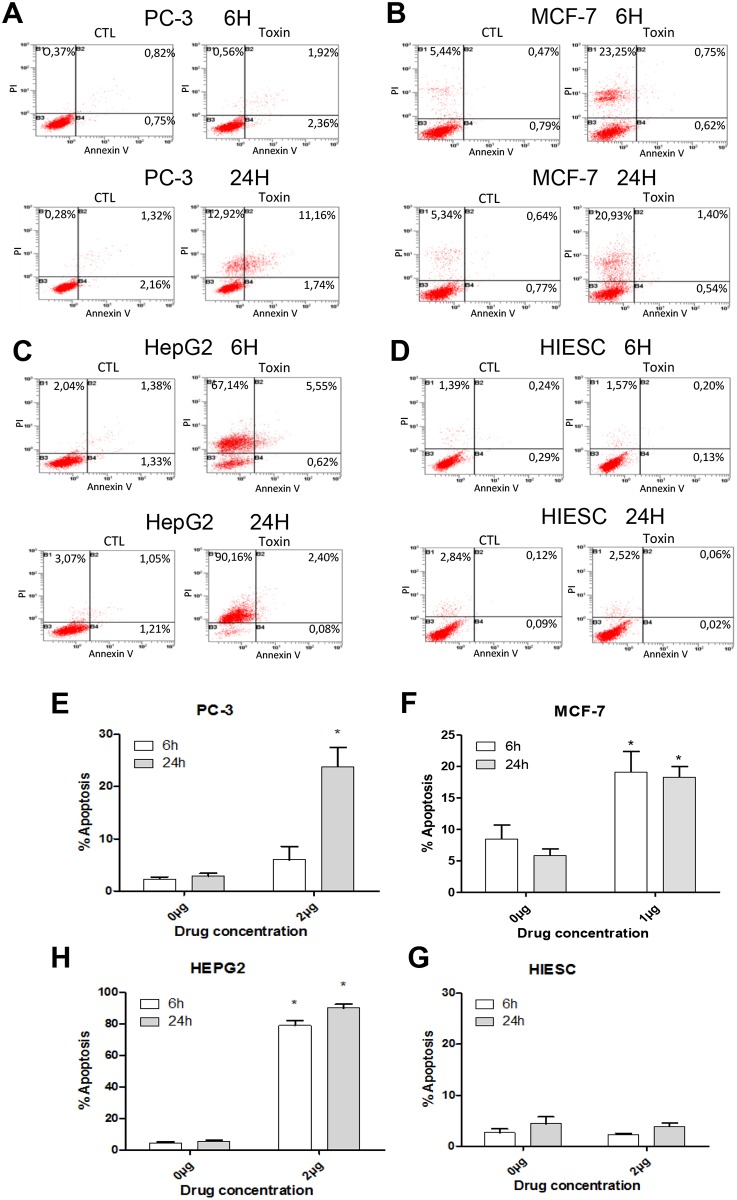

Bacillus thuringiensis 4R2 toxin proteins induce apoptosis in human cancer cells.PC-3 (A), MCF-7 (B), HepG2 (C) and HIESC (D) cells were treated with B. thuringiensis 4R2 toxin proteins (1μg/mL (B) or 2μg/mL (A,C,D)) for 24 h. Annexin V and PI staining was detected by FACS analysis. Results are mean ± S.E.M. of three independent experiments. *P<0.05 compared with corresponding mock-treated cells.